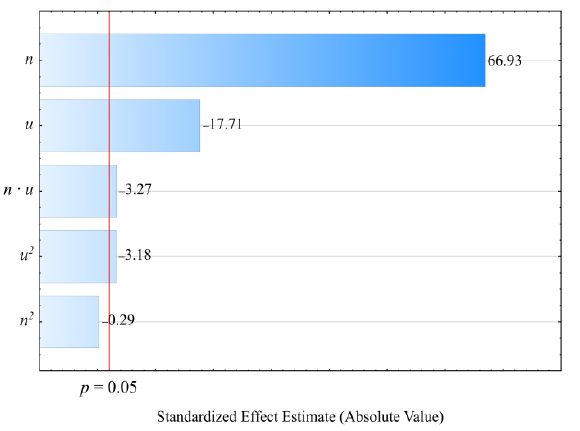
Figure 2. Pareto charts of the standardized effects for the empirical model G ; the vertical line in the plot corresponds to the arbitrarily chosen level of significance ( p = 0.05).